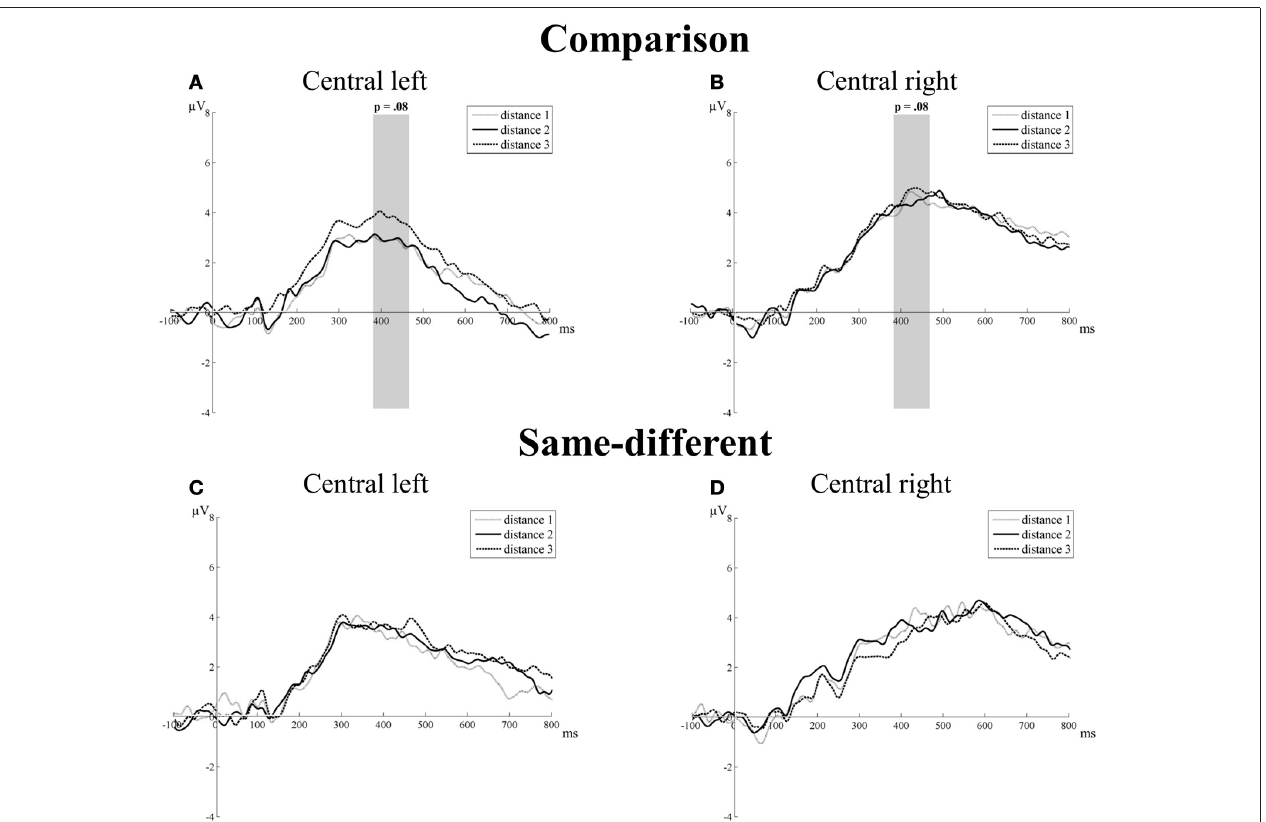
FIGURE 5 | Neural results for central electrode group of the comparison (A and B) and the same-different task (C and D) for the left and right hemisphere. Marginally significant distance effects are indicated with the corresponding p -value. A trend toward a distance